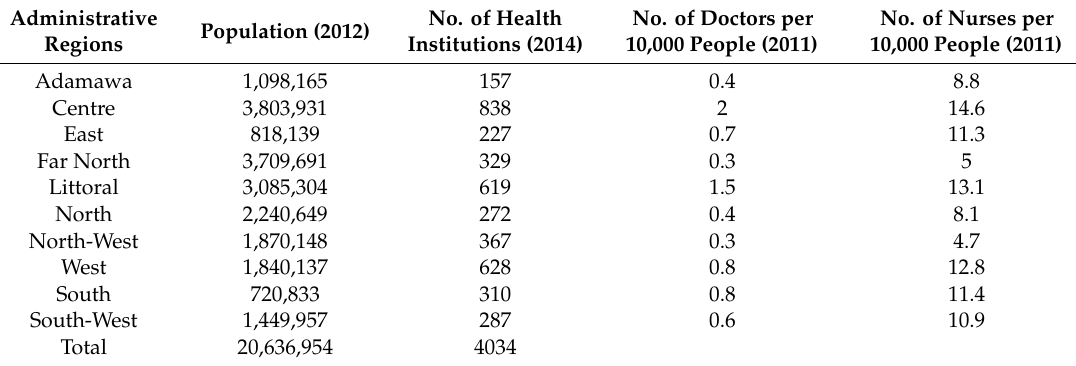
Table 1. Distribution of health facilities per region in